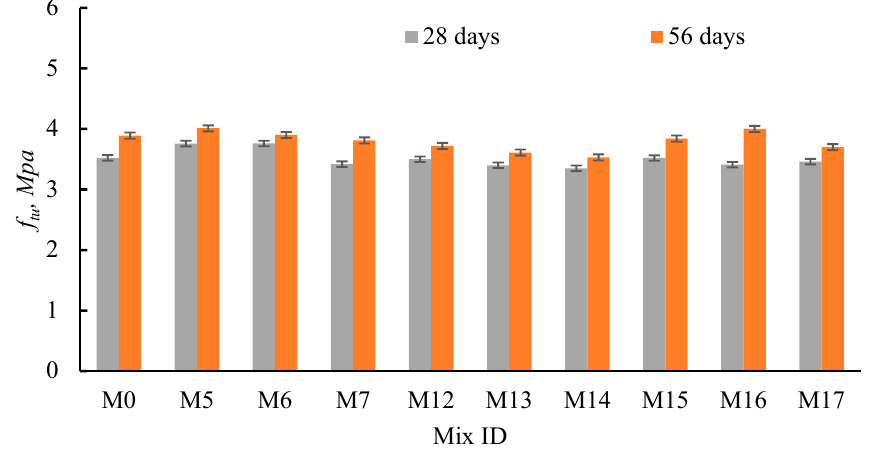
Figure 12. Effect of the RCP, AMF, and SF on concrete tensile strength.